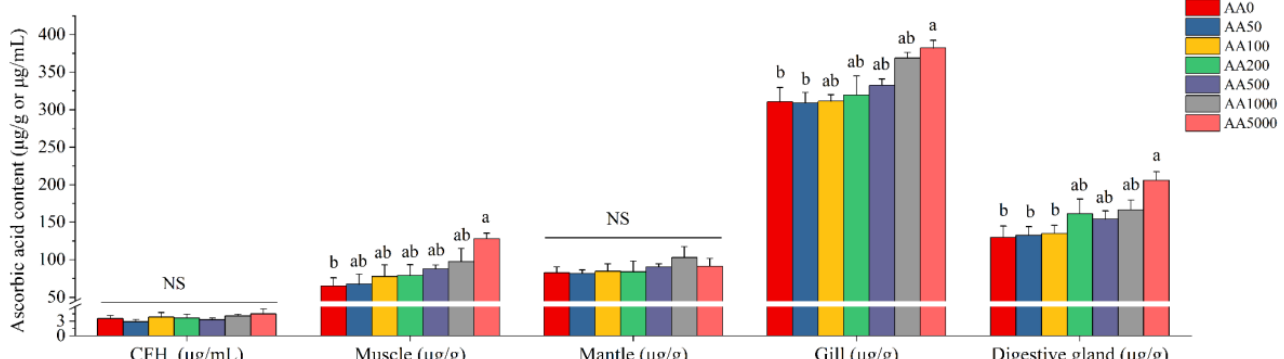
Figure 1. Ascorbic acid content in different tissues of abalone ( Haliotis discus hannai ) after a 100-day feeding trial. All data expressed as mean ± SE ( n = 3). The different lowercase letters indicate significant differences ( p < 0.05). NS: non-significant difference; CFH: cell-free hemolymph.